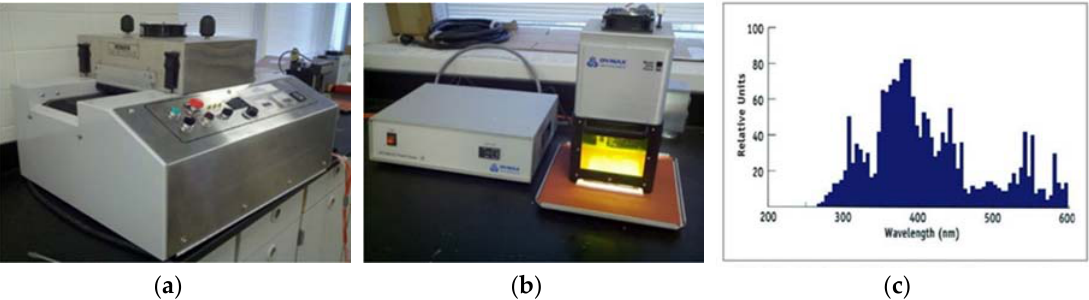
Figure 2. ( a ) Innovative Machine UV-100 ultraviolet curing system; ( b ) Dymax 5000 flood ultraviolet curing system; and ( c ) wavelength distribution of the curing system after optimization. Table 2. Technique specifications of the ultraviolet curing system.